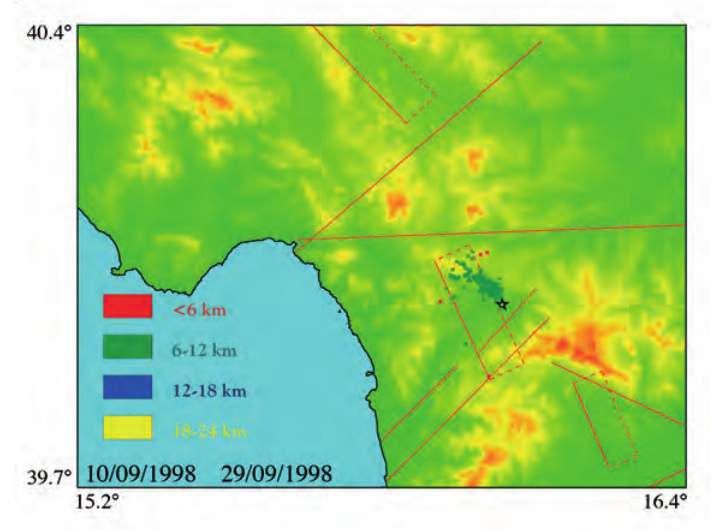
Fig. 8. Event locations in the time interval